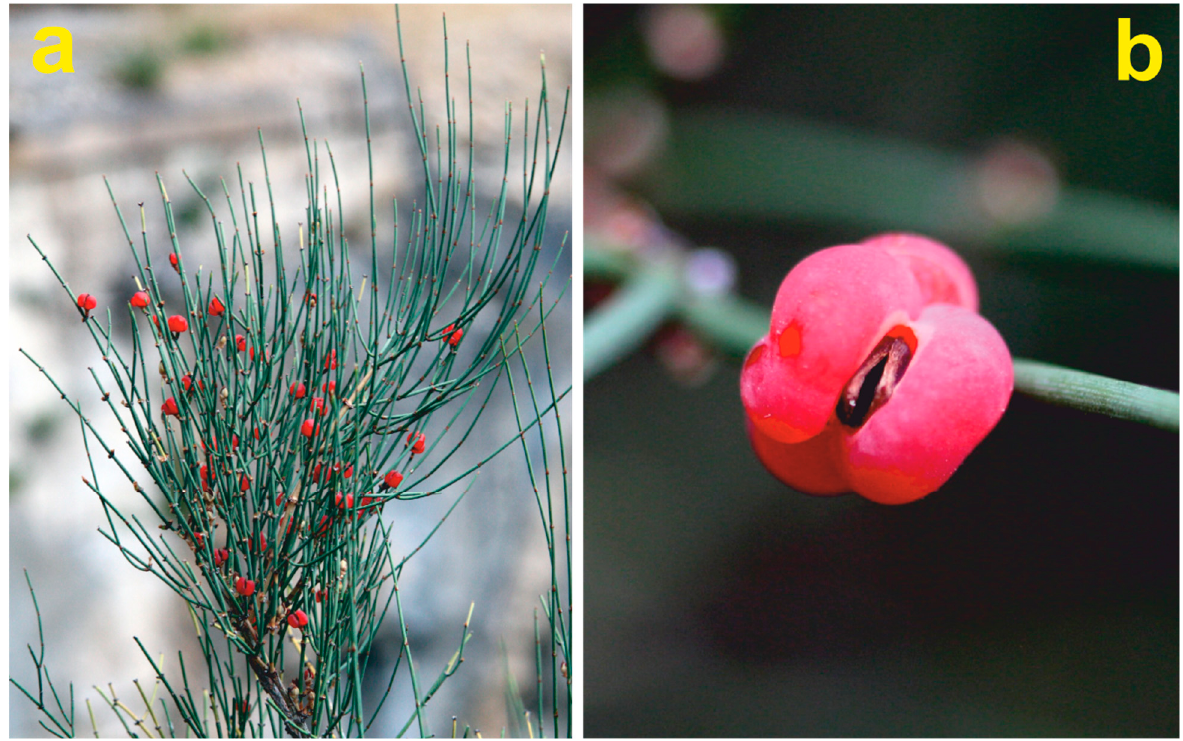
Figure 2. ( a ) Ramet of Ephedra major displaying many strobili in the mast year 2008; ( b ) Strobilus close ‐ up showing two inner seeds.